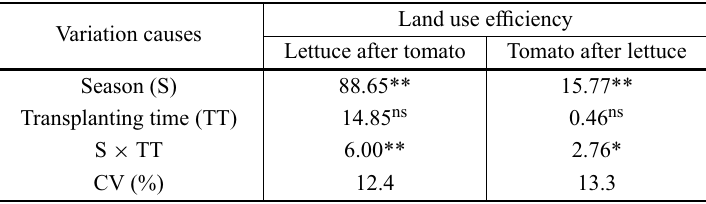
F values, significance and coefficients of variation of the land use efficiency (LUE) index, from the combined analysis of variance (cultivation periods: April 17 to September 9, 2003, and January 30 to July 25, 2004) of experi- ments in which lettuce was transplanted after tomato, and in experiments in which tomato was transplanted after